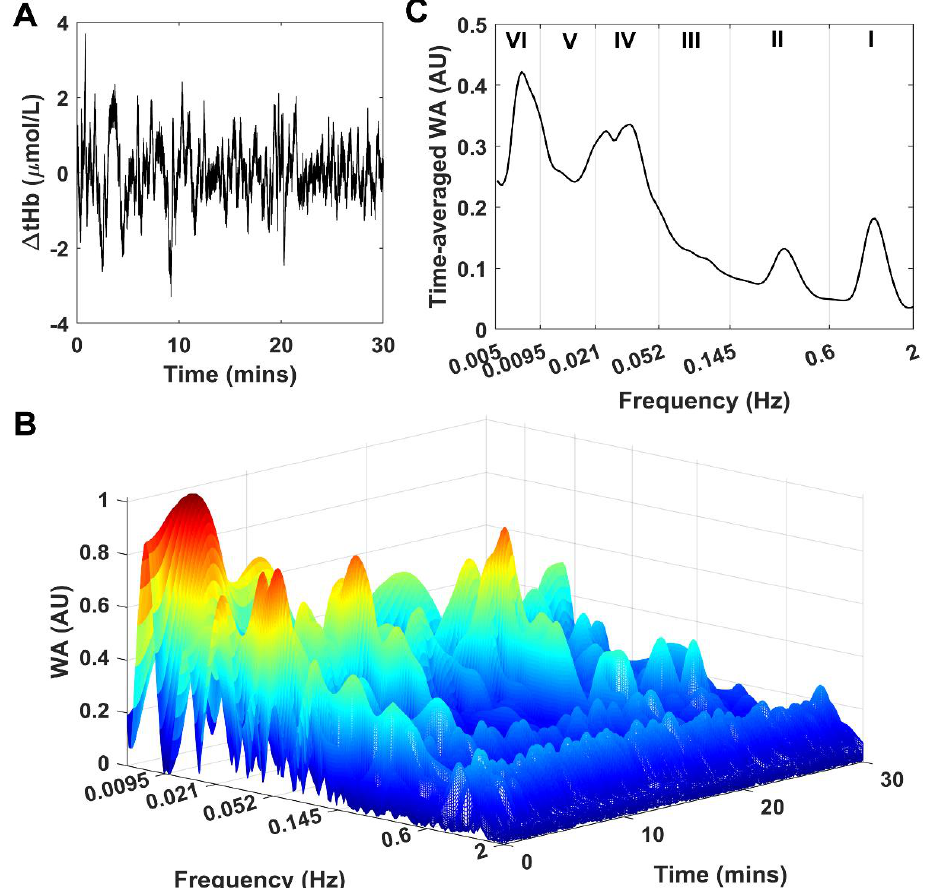
Figure 2. ( A ) One ∆ tHb signal recorded during a 30-min rest phase and filtered by 6th-order Butterworth filter. ( B ) The wavelet amplitude of the same ∆ tHb signal in time-frequency domain. ( C ) The time-averaged wavelet amplitude of the same signal with the frequency band divided into 6